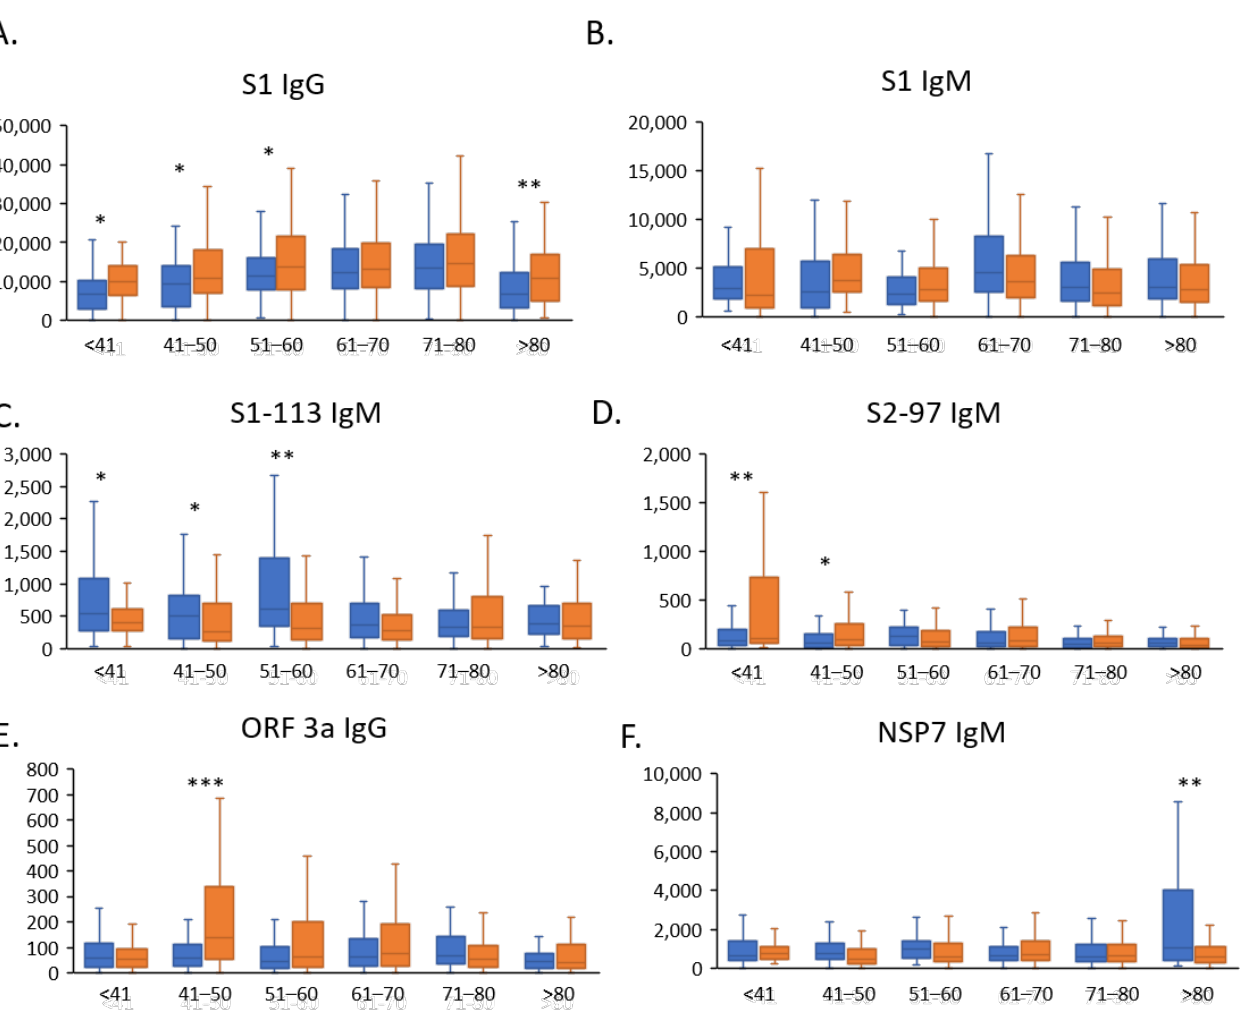
Figure 1. The severity-associated SARS-CoV-2-specific antibody responses in different age groups. The histogram shows the antibody responses for the spike protein ( A ) and N protein ( B ), spike protein peptides ( C , D ), and nonstructural proteins ORF 3a ( E ) and NSP7 ( F ) in COVID-19 patients with mild to severe disease in different age groups. Blue histograms represent mild patients and orange histograms represent severe patients. Blue = mild patients; Yellow = severe patients. * p < 0.05, ** p < 0.01, or *** p < 0.01 were considered statistically significant.